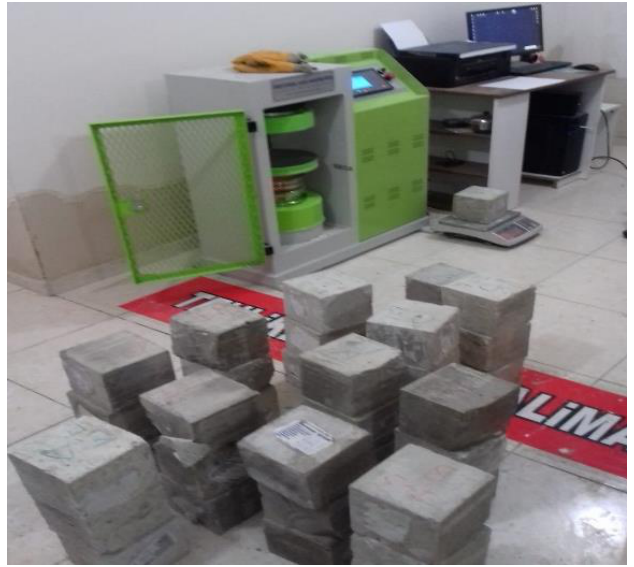
Figure 9. Samples prepared for compressive strength tests.